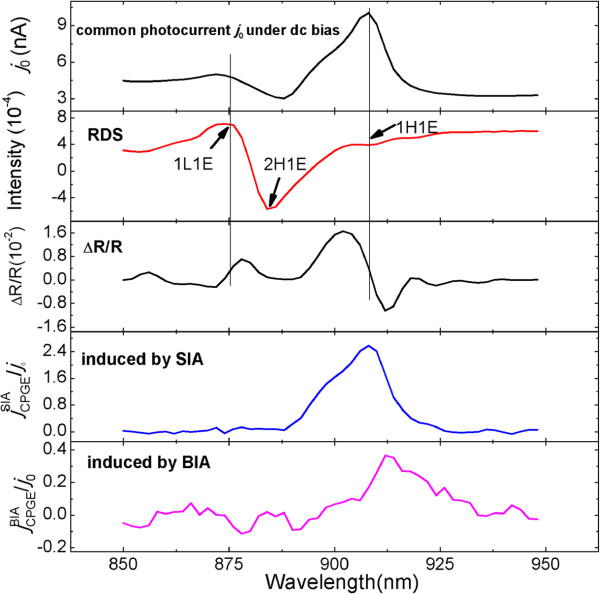
The comparison of different spectra in the In0.15Ga0.85As/GaAs/Al0.3Ga0.7As step QWs measured at room temperature. The spectrum of common photocurrent under dc bias (denoted as j0), the imaginary part of RD spectrum Δr/r, reflectance spectrum ΔR/R, and the normalized CPGE current induced by SIA and BIA in the step QWs.